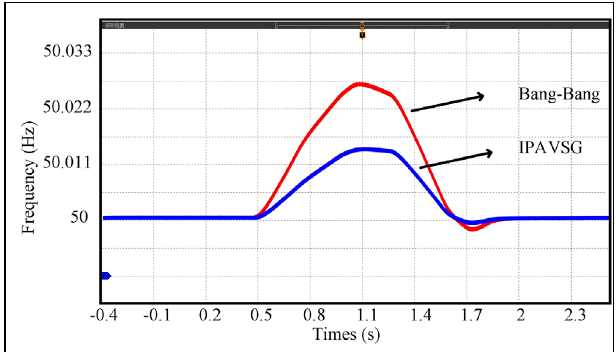
FIGURE 13 | Frequency outputs from IIDG1 and